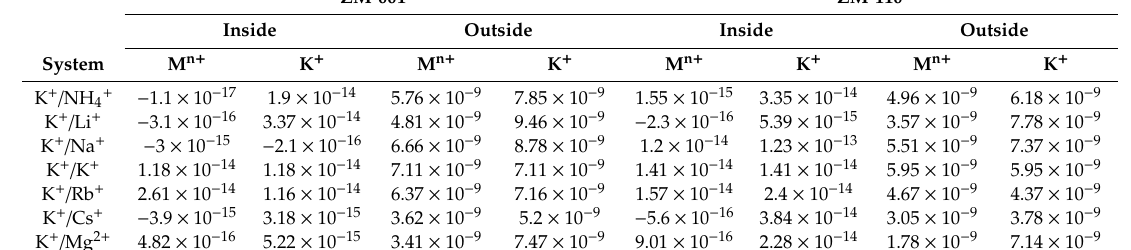
Table3. Self-diffusioncoefficientofionsinZM-001andZM-110membranesandintheelectrolytesolution. ZM-001